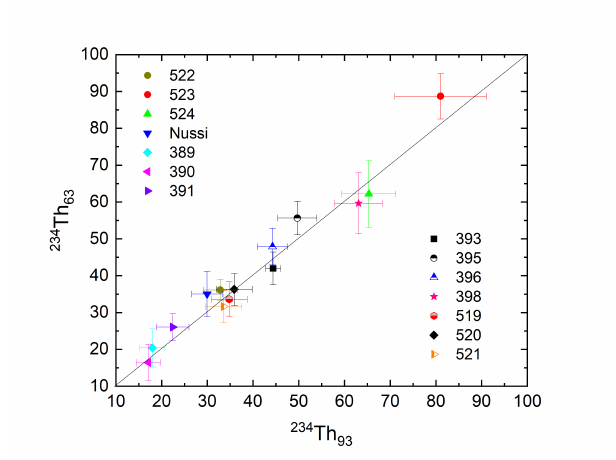
Figure 5. Testing the correction of the 63 and 92keV energy lines. Symbols represent sample codes of 14 samples originating from dif- ferent geographical regions and environments. Figure adapted from Abdualhadi et al.